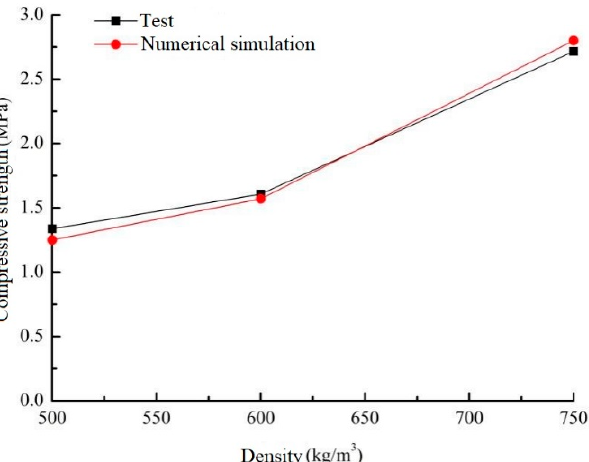
Figure 21. Relationship between the compressive strength and density of foam concrete in the test and the numerical simulation results.